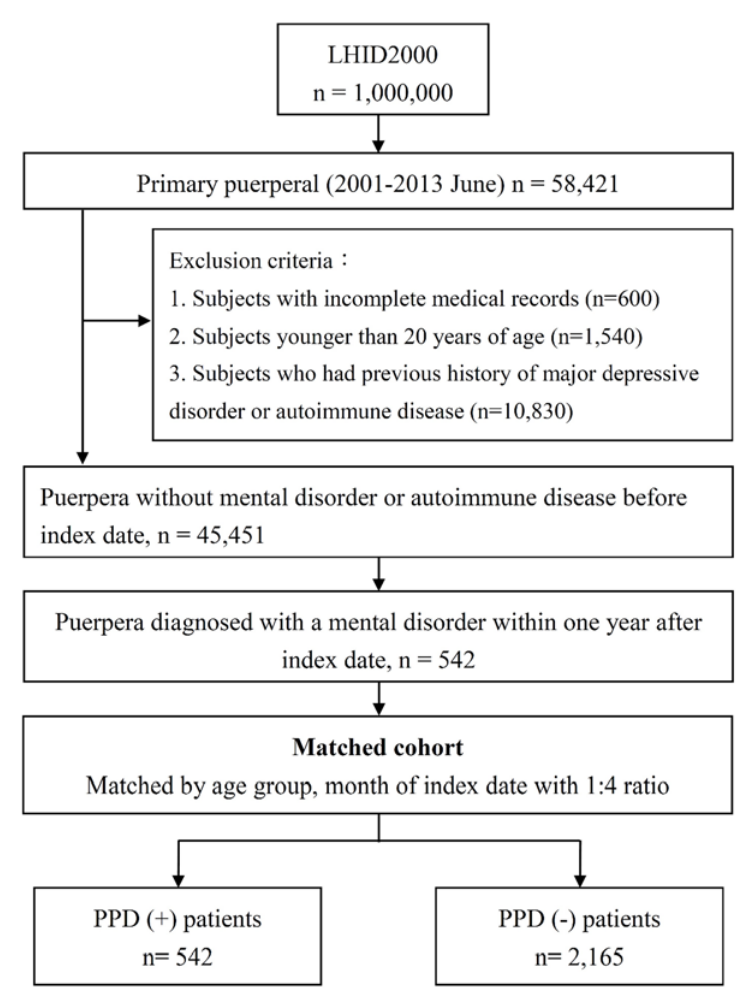
Figure 1. The flow chart for enrollment of study cohorts.